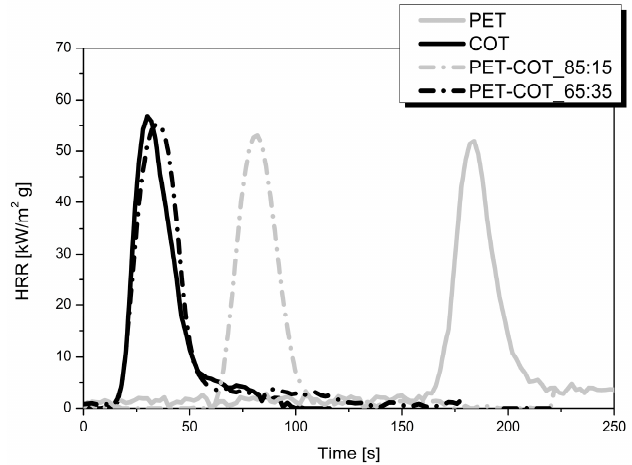
Figure 4. Heat Release Rate (HRR) curves of PET, COT, PET-COT_85:15 PET-COT_65:35 fabrics. Data obtained by cone calorimetry under 35 kW/m 2 .